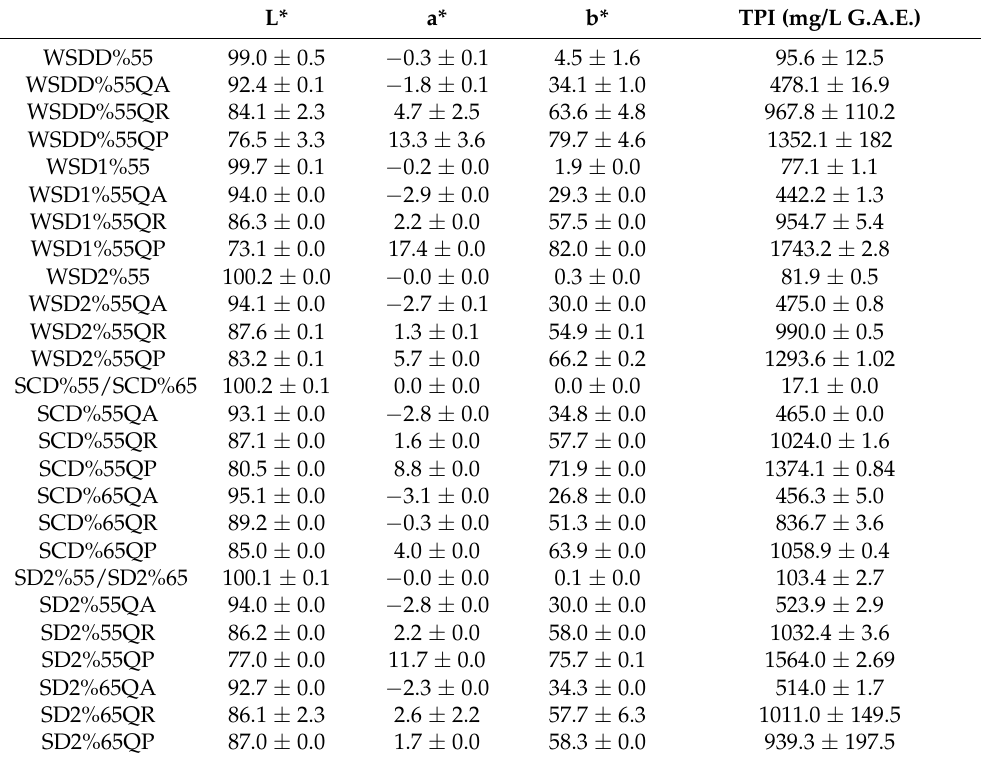
Table 4. Chromatic characteristics and TPI of the young and aged spirits. The values are expressed as the mean ± standard